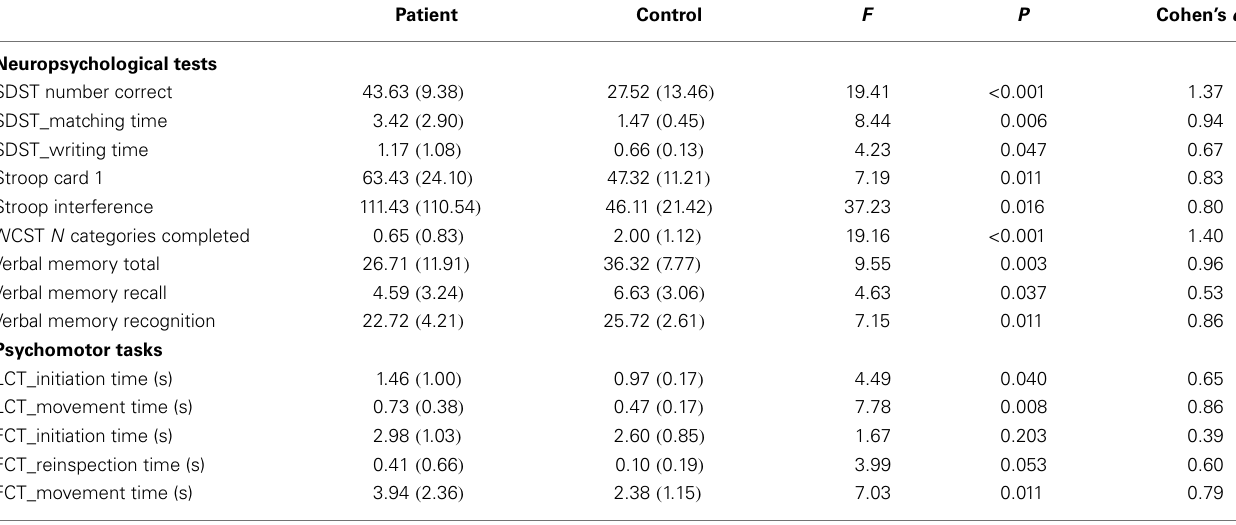
Table 2 | Mean performance levels of patients and controls on cognitive and psychomotor measures .